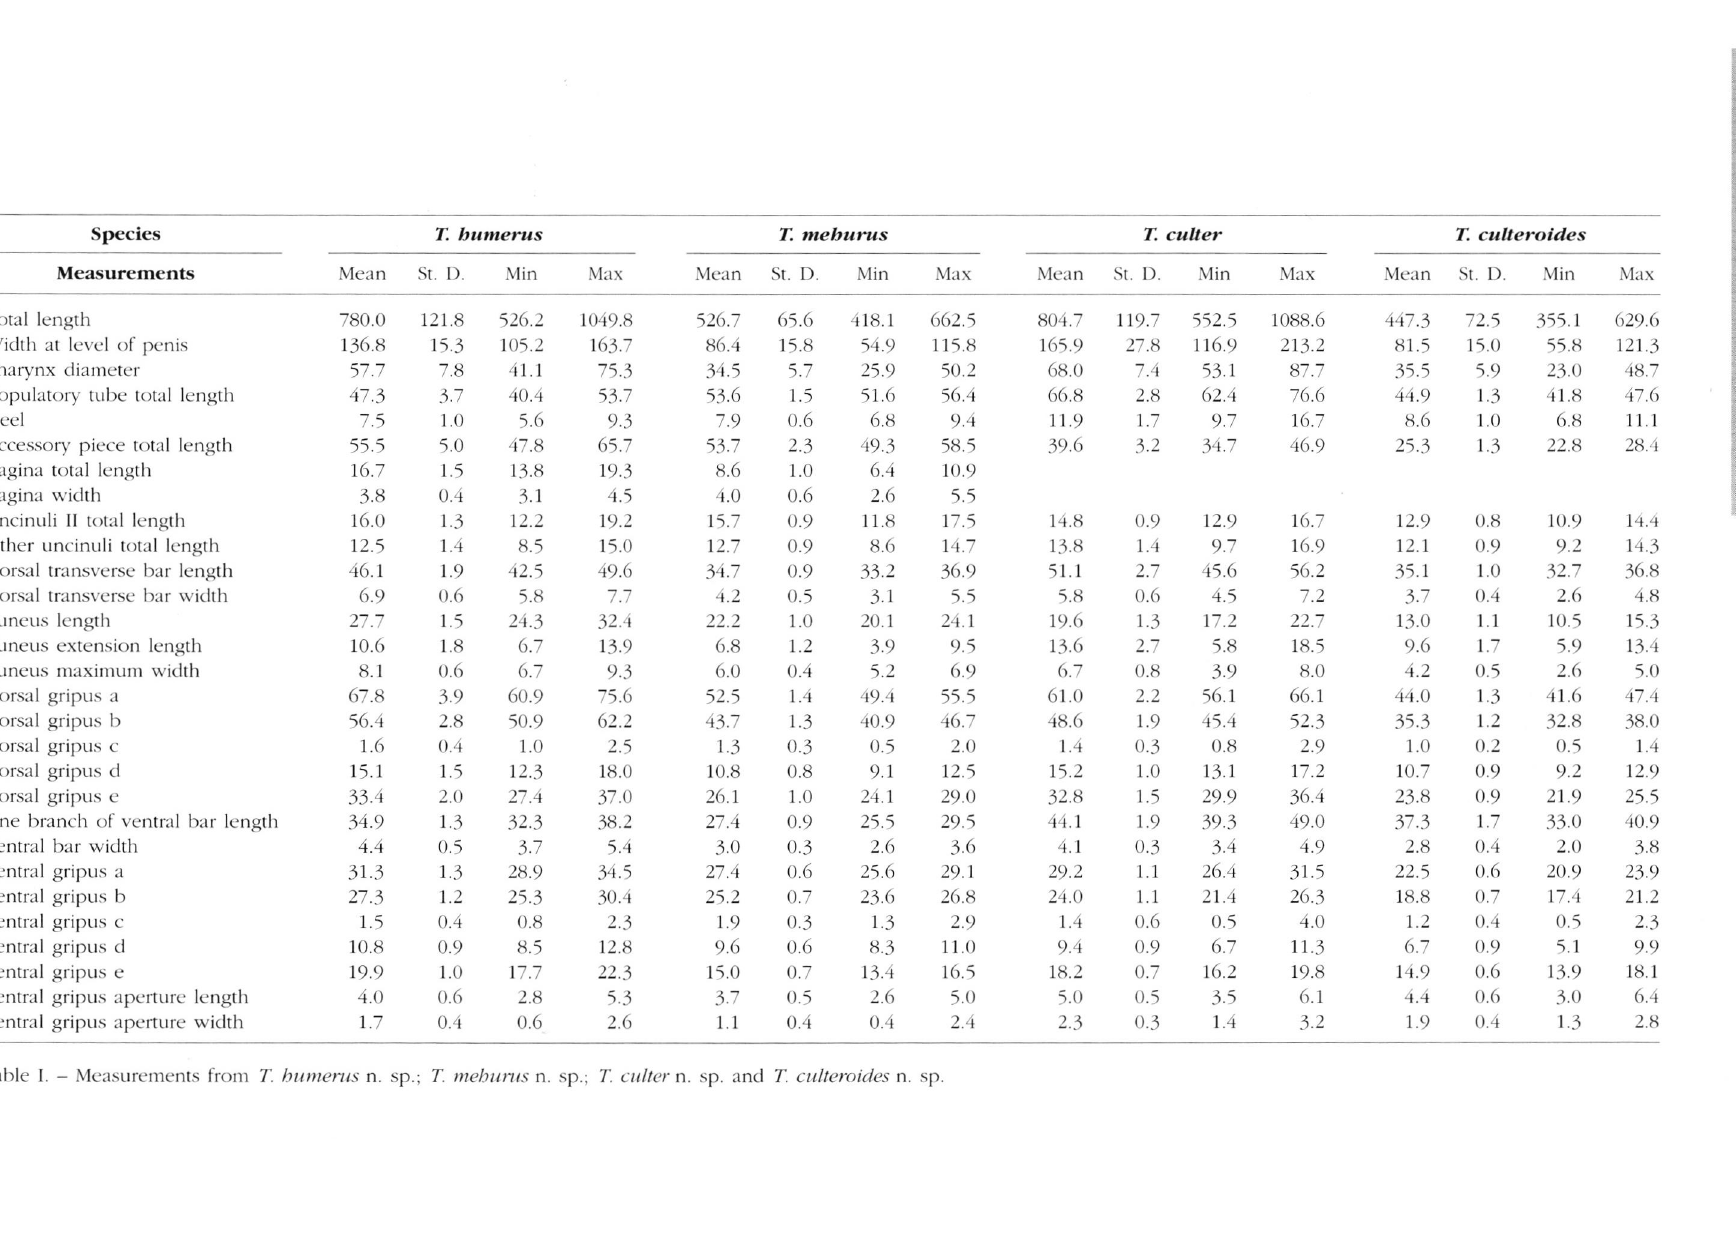
P A R I S ELLE A